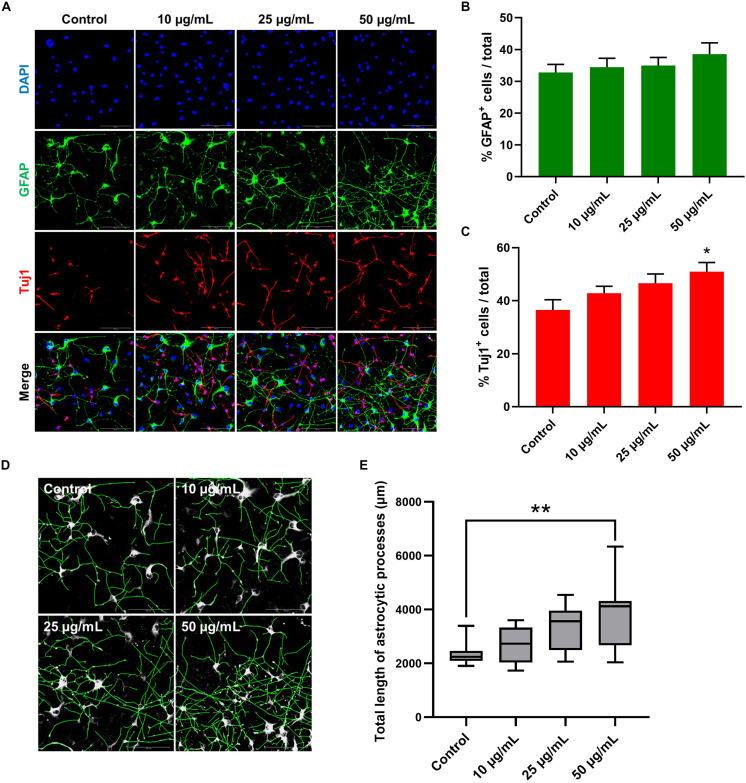
Effects of STEE on hNSC differentiation. hNSCs were cultured as a monolayer for 7 days in differentiation medium only (control cells) or in differentiation medium with different concentrations of STEE (treatment cells). Immunostained cells were visualized by confocal microscopy. (A) Fluorescence images of immunocytochemistry for astrocytic marker GFAP and neuronal marker Tuj1 in the control and STEE-treated cells. Scale bar = 100 μm. (B,C) Quantification of GFAP or Tuj1 positive cells over total cells visualized with DAPI. Results are expressed as relative percentages. Comparisons were performed using one-way ANOVA followed by Dunnett’s post hoc test: *p < 0.05. Error bars represent the ± SEM (n = 8–10 sections per culture). (D) Effects of STEE on the length of astrocytic processes. Representative images of outlined GFAP positive processes, and (E) quantification of total length of the processes. Results are shown as box plots. Each box ranges from 25th to 75th percentile, the line in the middle represents the median value, the error bar represents the ± SEM (n = 8–10 sections per culture). Asterisks refer to statistical significance by Kruskal–Wallis test followed by Dunn’s post hoc test: **p < 0.01.